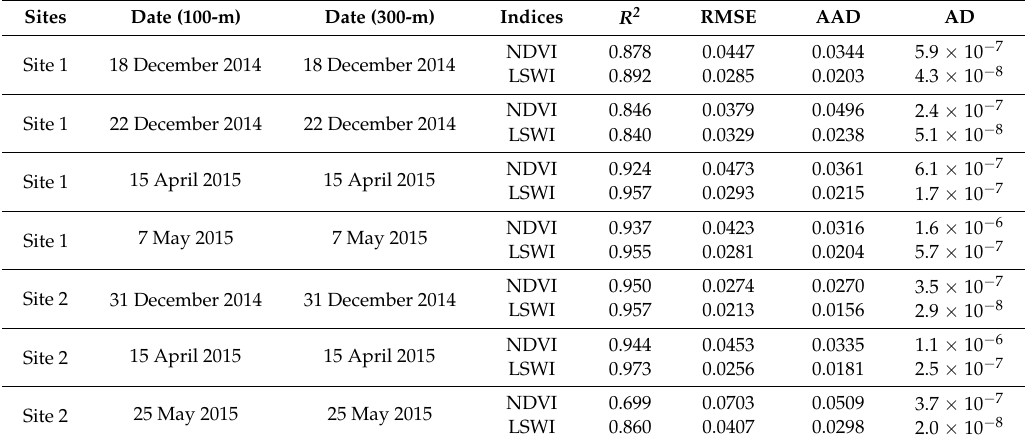
Table 6. Results for the NDVI and LSWI accuracy assessment of the referenced PROBA-V 100-m images compared to the ESTARFM predicted